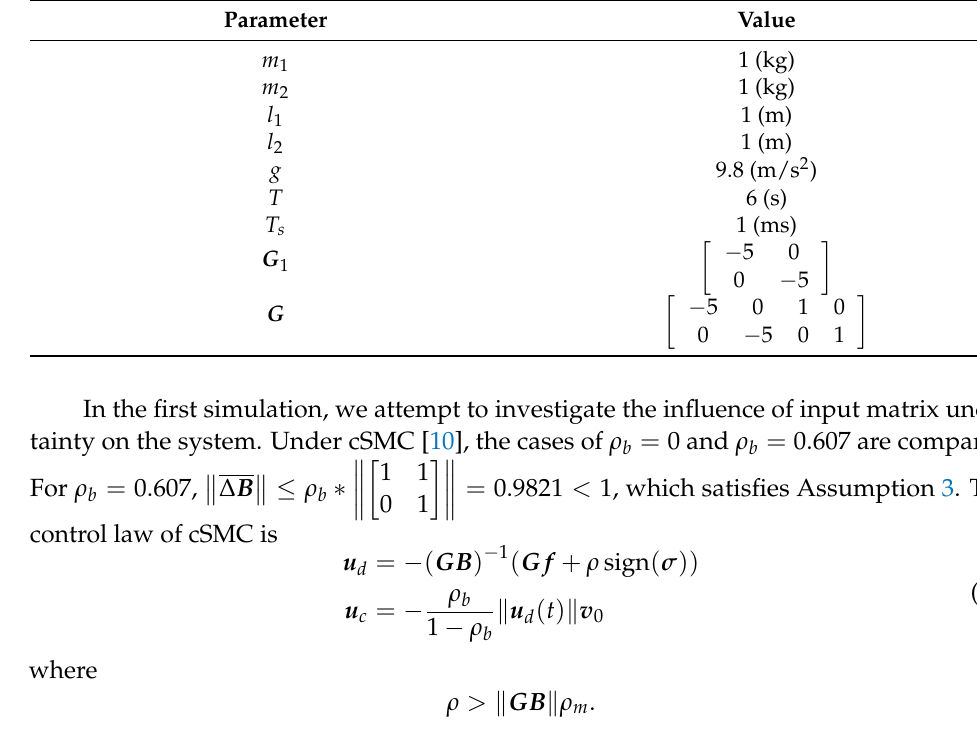
Table 3. Parameter